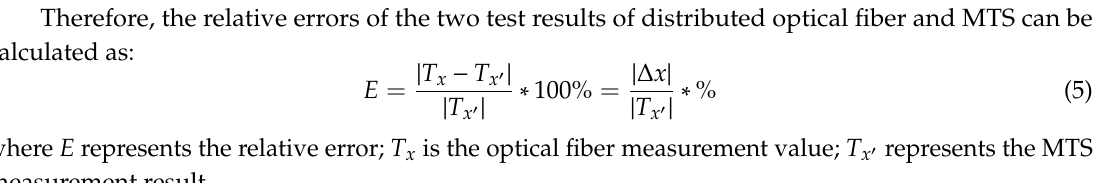
Figure 8. Stress–strain results of the adjacent points of the circumferential strain gauge.